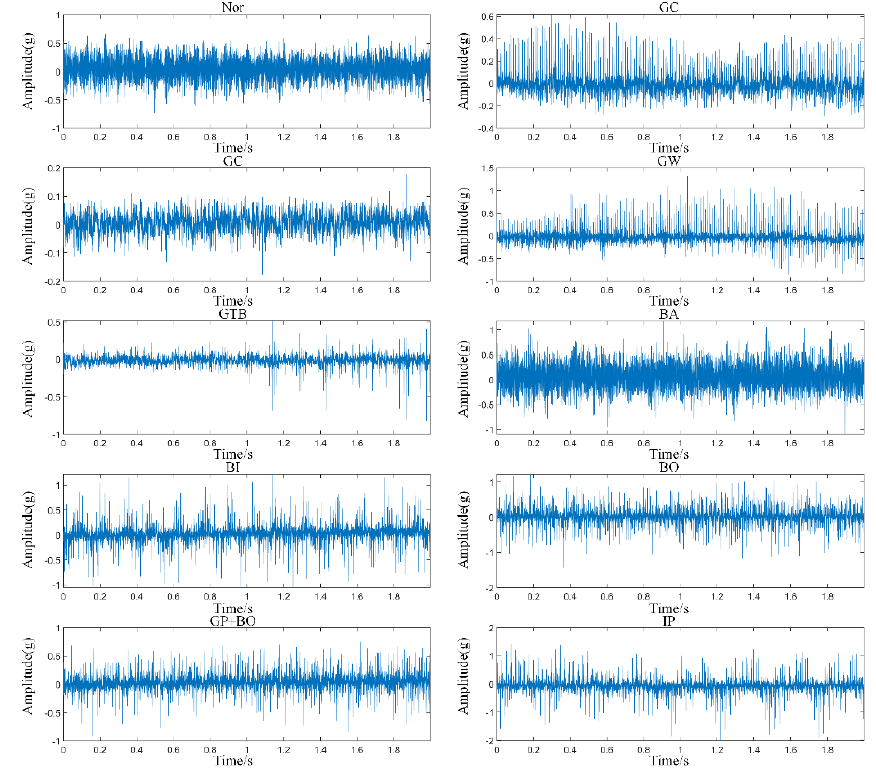
Figure 18. Waveforms corresponding to different states.